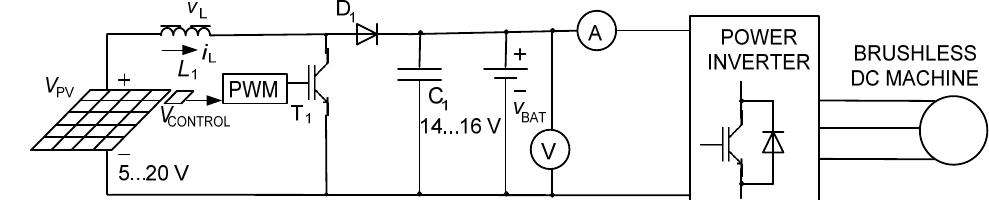
Figure 3. Designed PV system with Boost power converter and MPPT function connected to a commercial fixed-wing radio-controlled aircraft propulsion system.